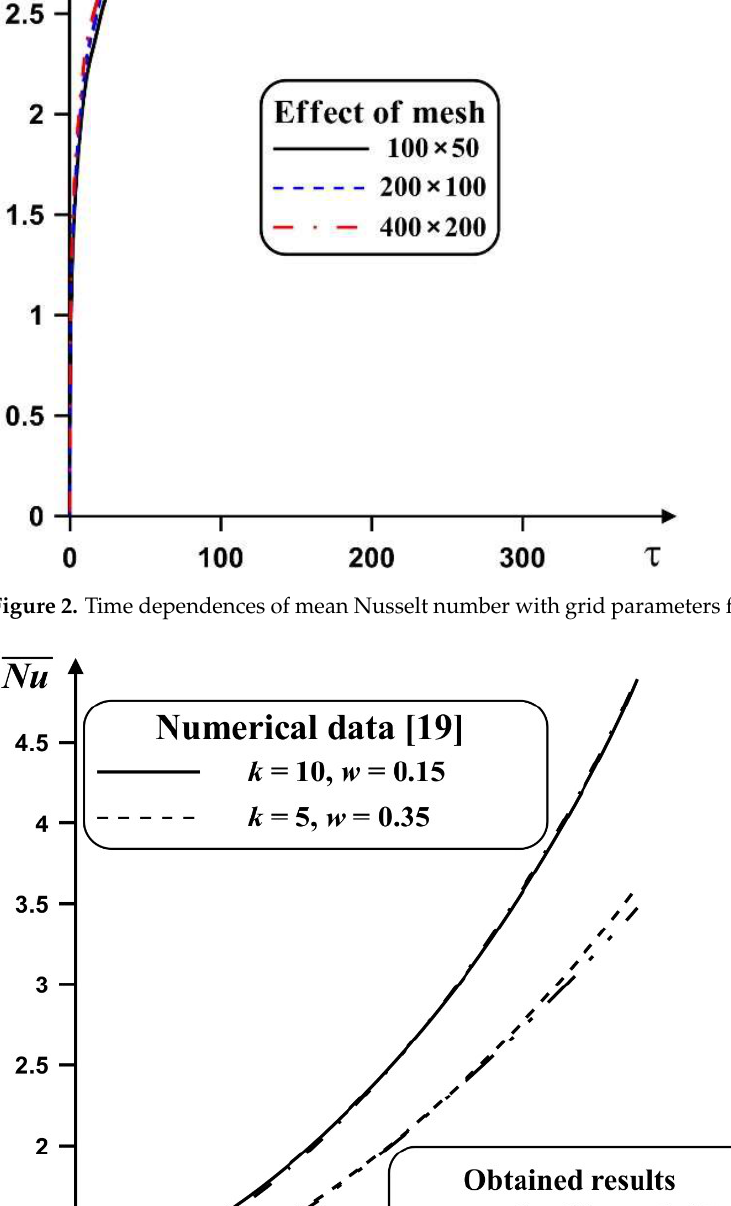
Figure 2. Time dependences of mean Nusselt number with grid parameters for Pr = 6.82 ans Ra = 10 5 .